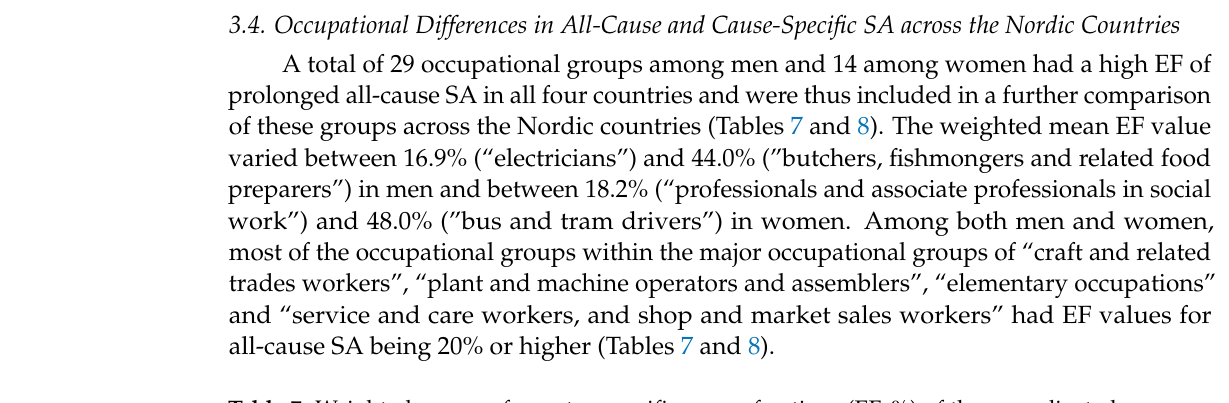
Table 7. Weighted means of country-specific excess fractions (EF, %) of the age-adjusted one-year cumulative incidence of prolonged sickness absence (SA) among men. Only occupational groups with statistically significant excess fractions in all countries are